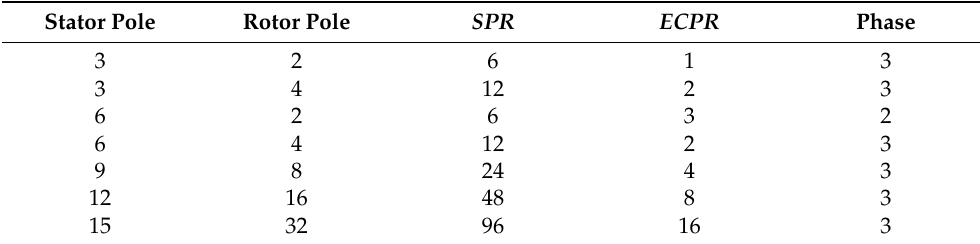
Table 1. Pole number analysis in a PMM.